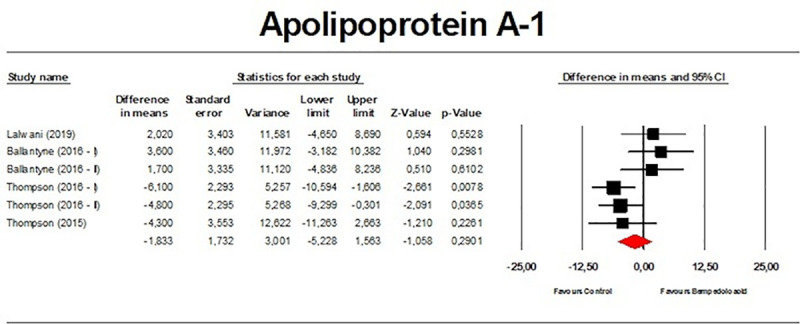
Forest plot displaying mean difference and 95% confidence intervals for the effect of bempedoic acid on plasma levels of apolipoprotein A-1.